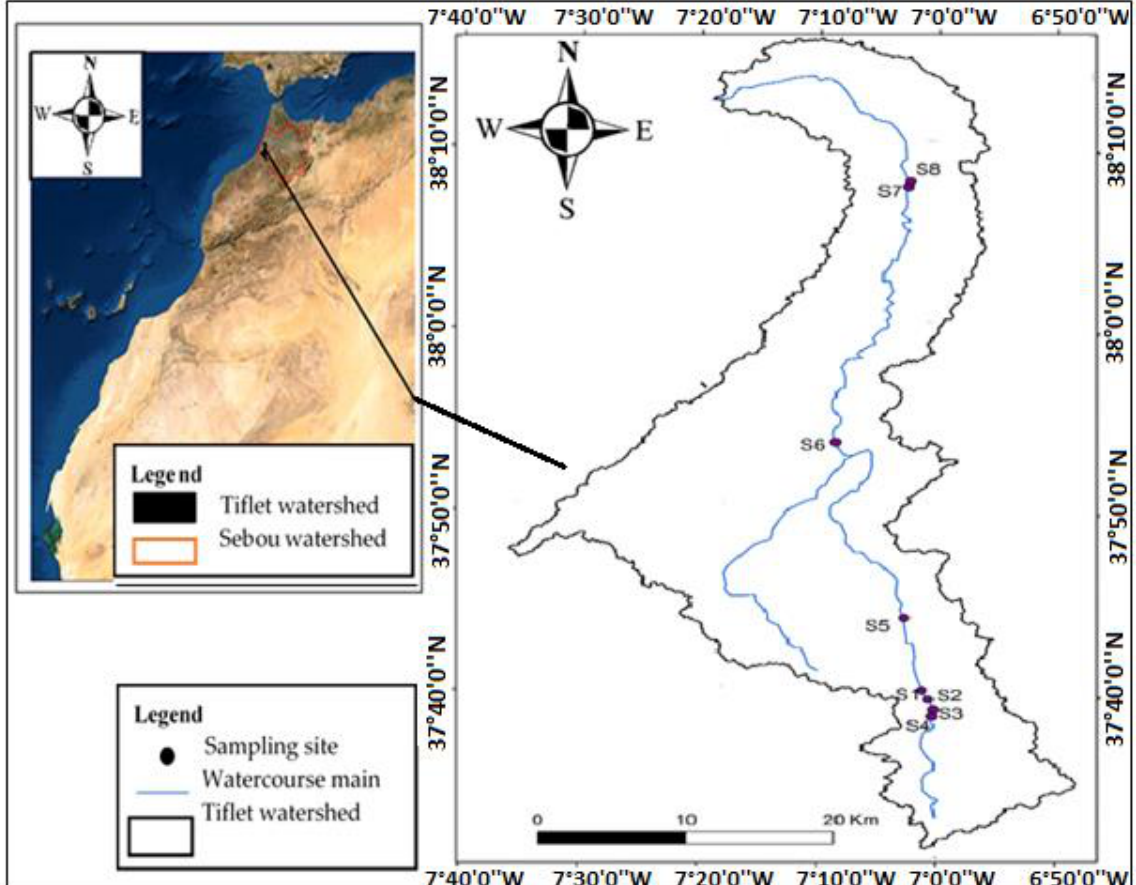
Figure 1. Oued Tiflet water-quality monitoring stations.